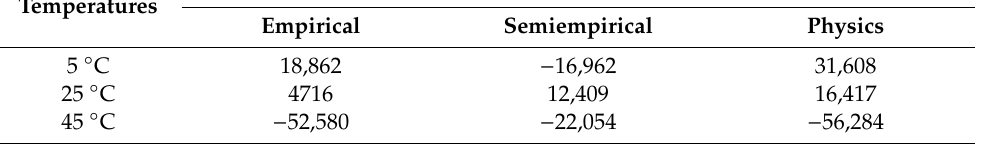
Table 3. Profit at the end of a 1-year capacity market contract fora battery with a de-rating factor of 1 h when using several degradation models.